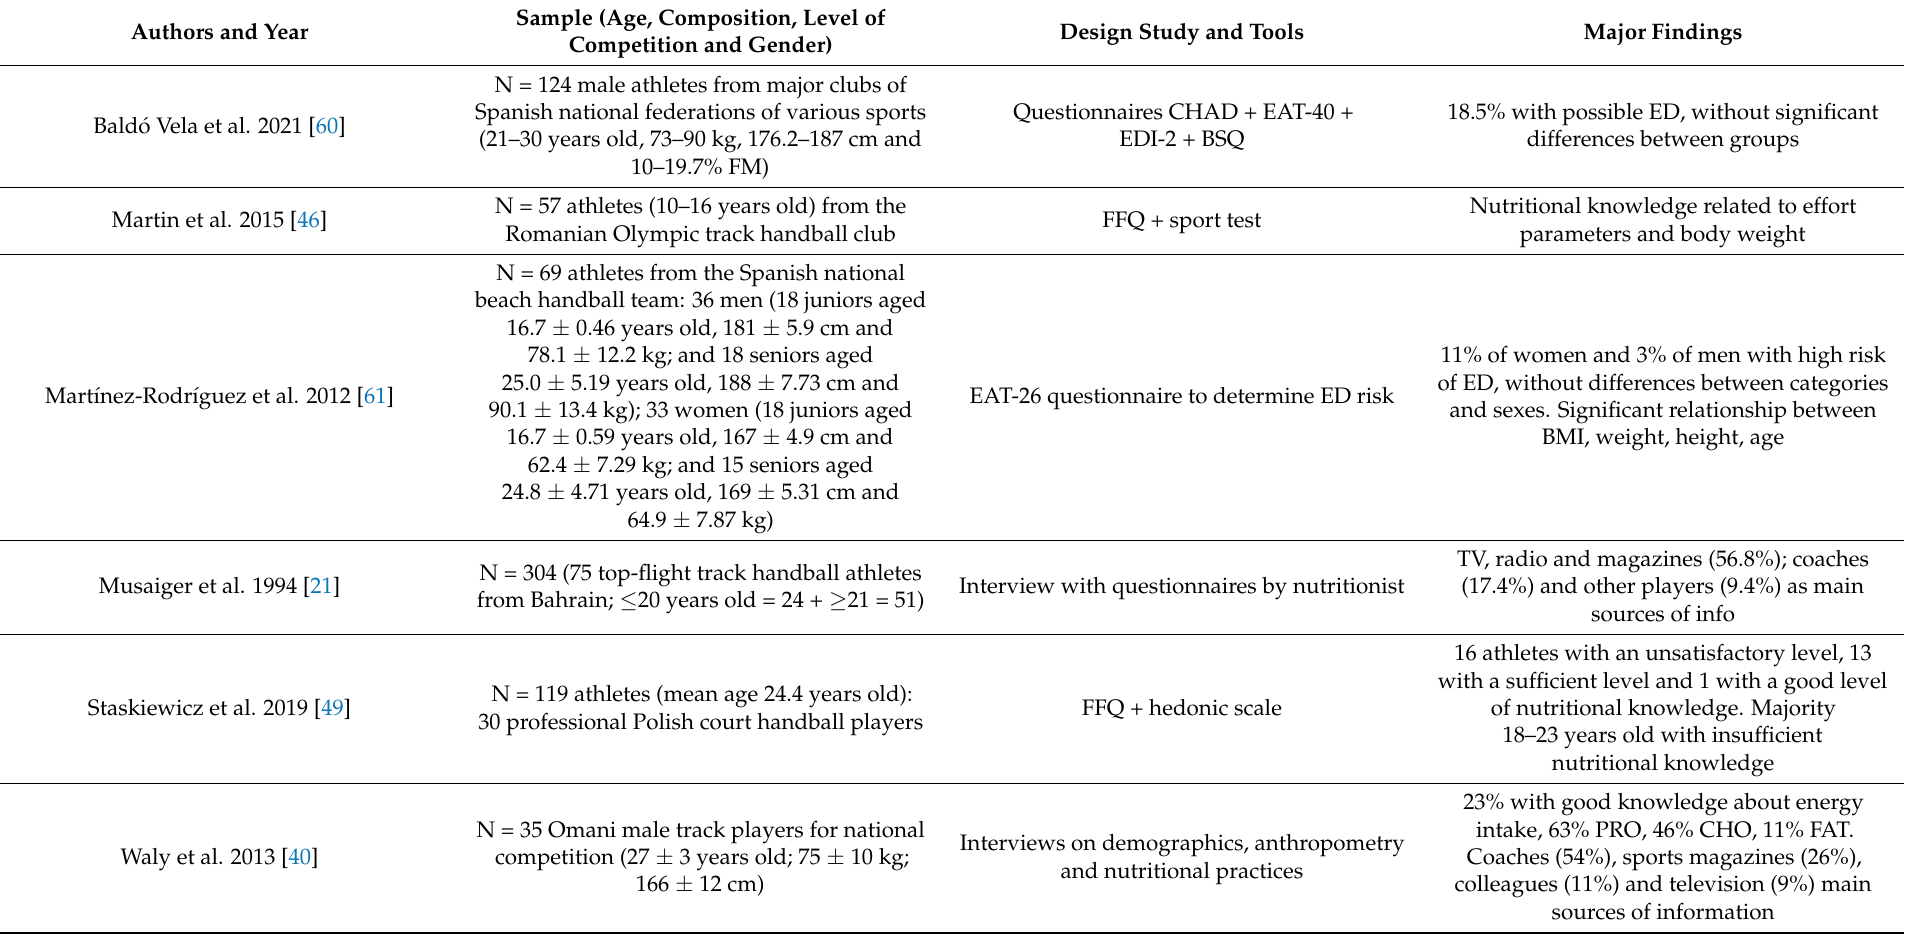
Table 4. Knowledge about sports nutrition and prevalence of eating